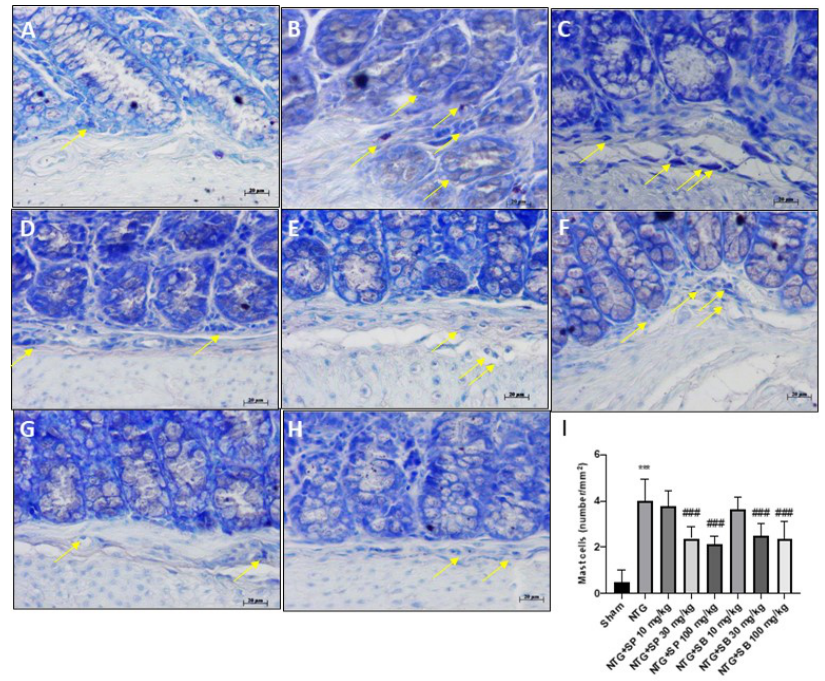
Figure 2. SCFAs treatment reduced mast cell content. Blue toluidine staining revealed that NTG group was characterized by high mast cell content ( B ) compared to sham group ( A ), however the treatment with SCFAs at higher doses significantly reduced mast cell infiltration ( D , E , G , H ). No significant difference was revealed in mice treated with 10 mg/kg of SCFAs ( C , F ). The yellow arrows indicated positive cells. ( I ) *** p < 0.001 vs. sham; ### p < 0.001 vs. NTG.